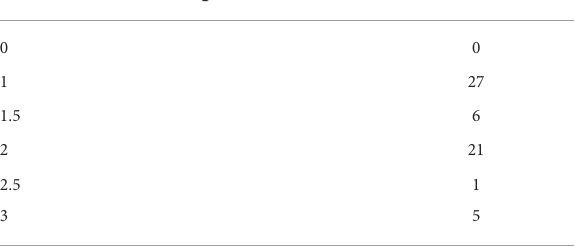
TABLE 1 Distribution of countries on the Government responses to GBV index.